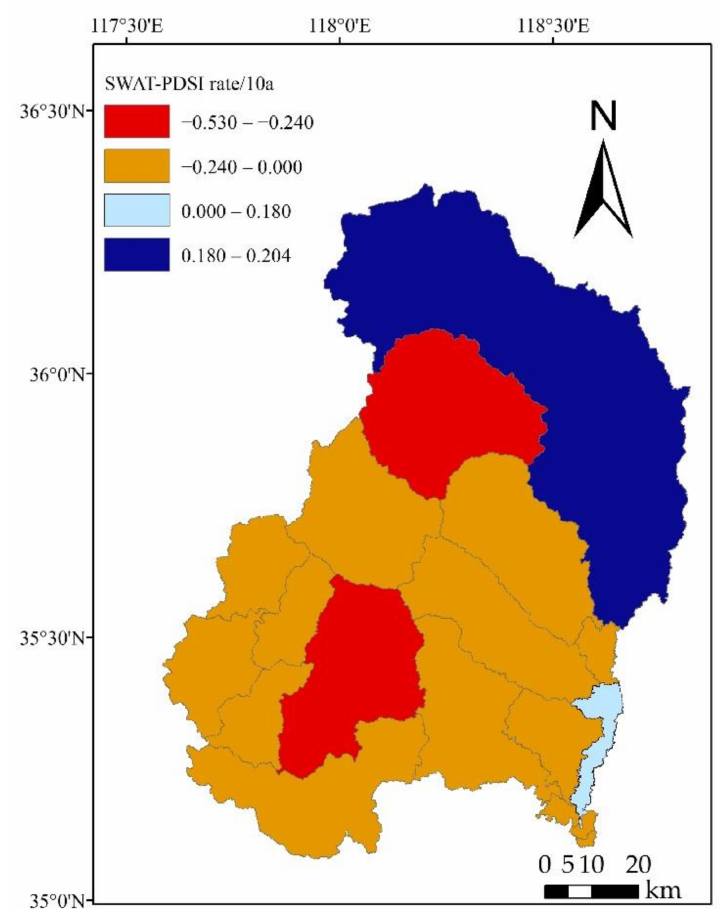
Figure 4. Annual average SWAT–PDSI spatial change rates in the 18 sub-basins of the Yihe River from 1980 to